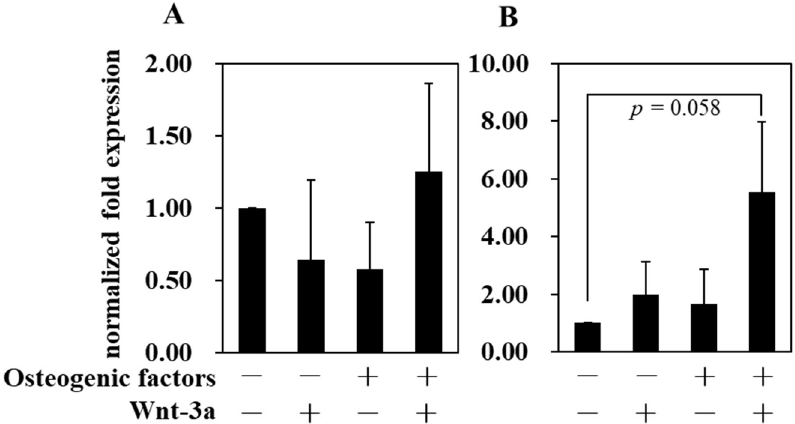
Figure 6. Gene expression analysis after treatment with Wnt-3a by real time quantitative PCR. HPLFs were treated with osteoblast medium and Wnt-3a for 14 days. Tendon-specific genes (( A ) Mkx , ( B ) Scx ). The expression level of the Mkx gene was not significantly different between the mediums, but it tended to be suppressed by (+/−) medium and increased by (+/+) medium. The expression level of the Scx gene showed a tendency to increase in (+/+) medium. Data represent the means ± S.D.